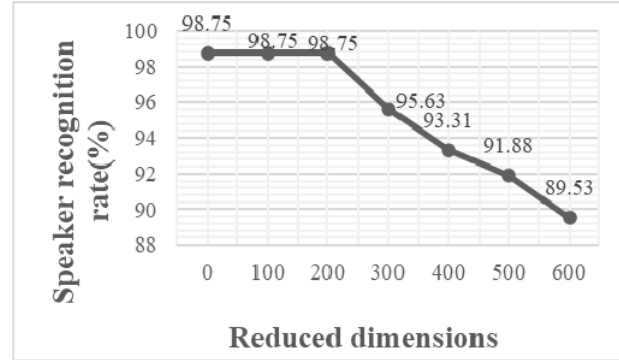
Figure 12. Speaker recognition rate based on Fisher criterion feature selection.